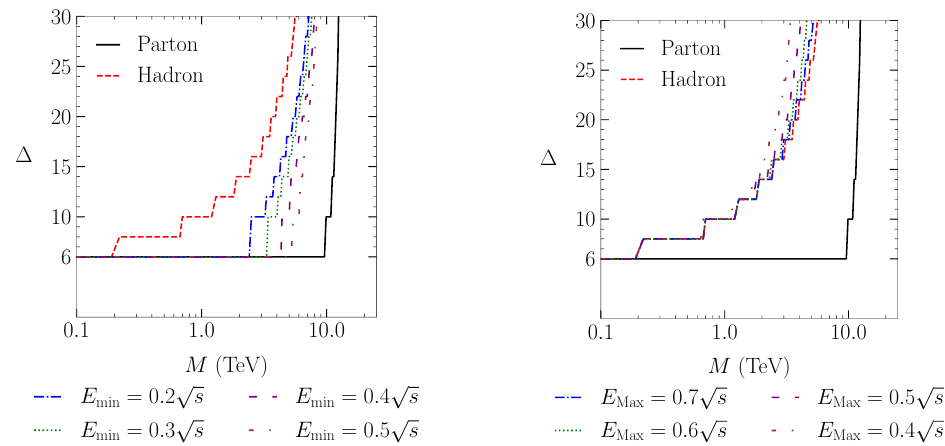
Figure 21 . Perturbative unitarity bounds in the ∆ versus M plane for various choices of a minimum energy cut E min [left] and of a maximum energy cut E max [right] for the t -channel model with λ qφ = 8 π in the case that the final state particles have a mass of 10 GeV. The region that is incompatible with hadronic perturbative partial-wave unitarity is to the left of the